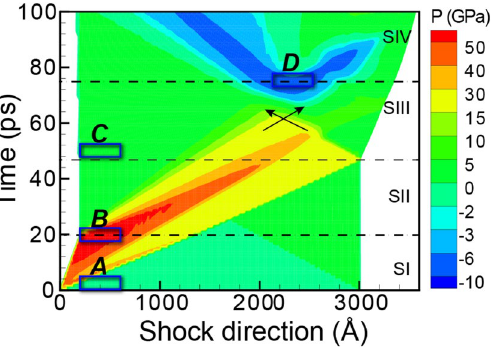
Figure 7. The temporal evolution of pressure for shocked Cu. The stages of shock are separated by dashed lines, and the region of triaxial tension is indicated by black arrows. Blue rectangles, labeled A–D, mark the regions examined in Fig. 8 and Table S3.